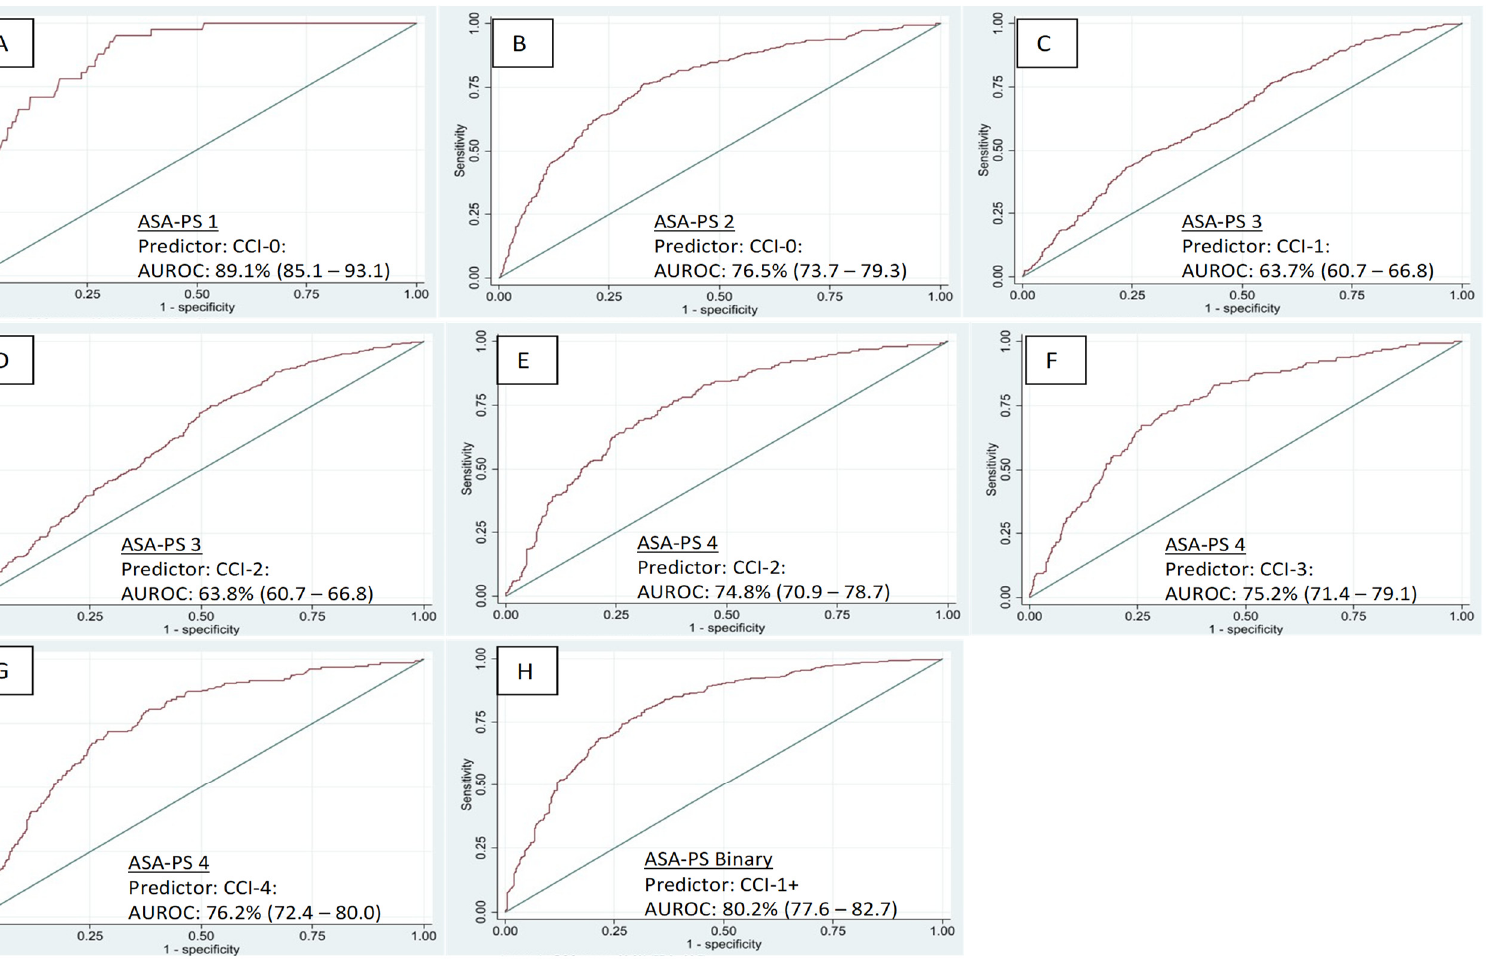
Figure 3. Area under the receiver operating characteristic curve assessing the accuracy of the most predictive CCI category in predicting each ASA-PS grade using the test dataset. ( A ) CCI-0 as a predictor of ASA-PS 1; ( B ) CCI-0 as a predictor of ASA-PS 2; ( C ) CCI-1 as a predictor of ASA-PS 3; ( D ) CCI-2 as a predictor of ASA-PS 3; ( E ) CCI-2 as a predictor of ASA-PS 4; ( F ) CCI-3 as a predictor of ASA-PS 4; ( G ) CCI-4 as a predictor of ASA-PS 4; ( H ) CCI-1+ as a predictor of ASA-PS Binary